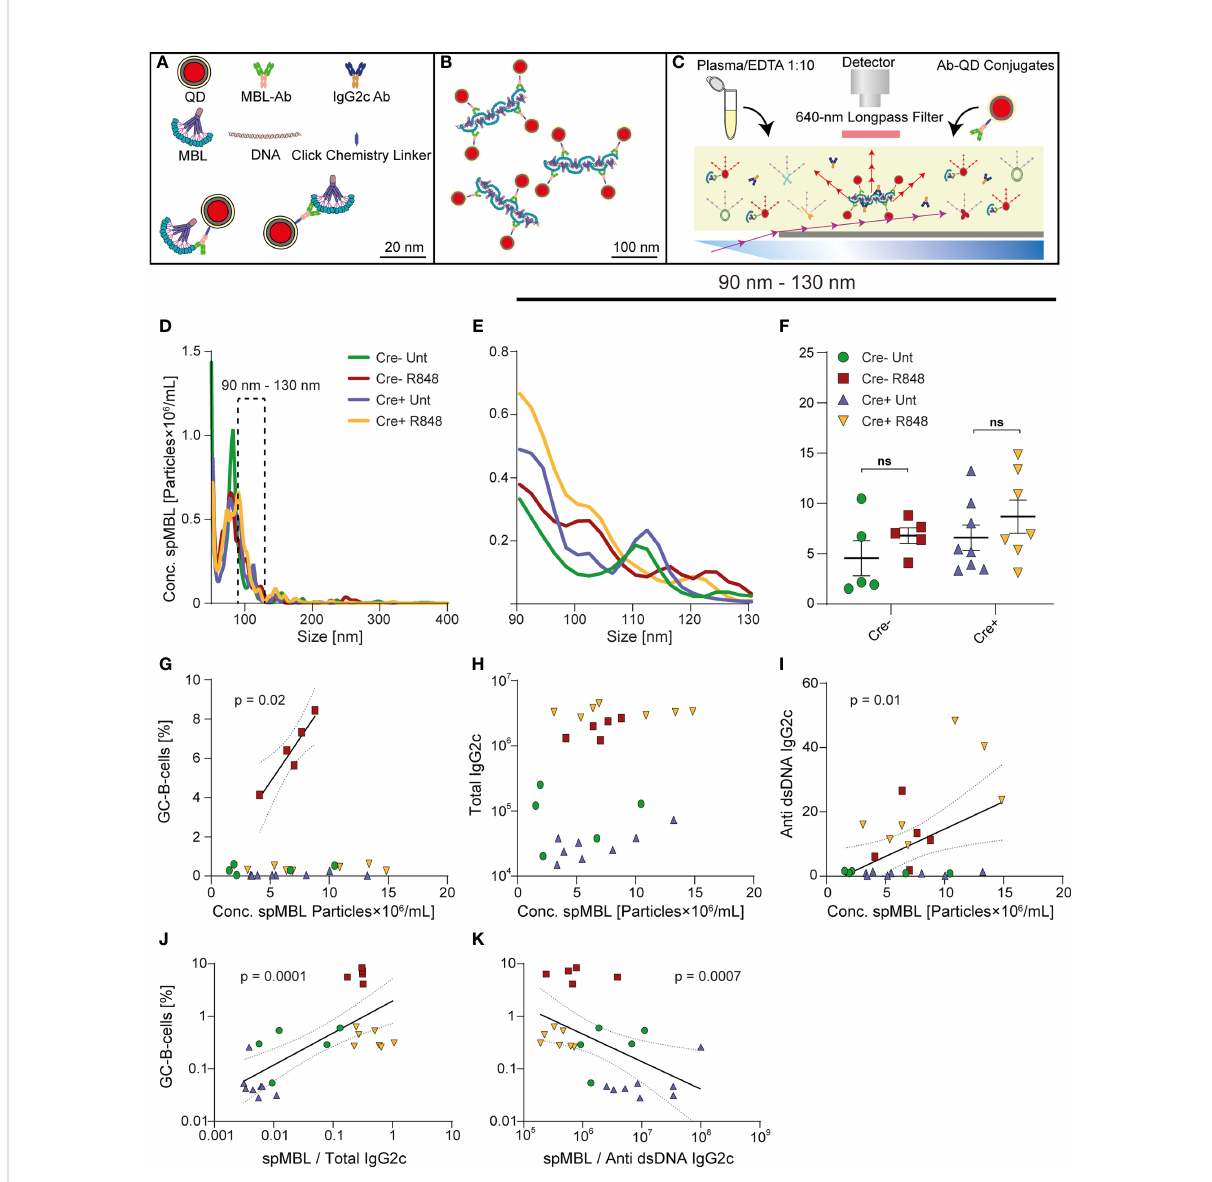
FIGURE 2 Trend towards increased levels of spMBL particles in serum from Cre+ R848 treated mice, and GC and autoantibody correlations with spMBL. (A – C) Schematic overview of experimental setup for spMBL analysis of serum samples. (D) Samples were tested for the size interval 90-130 nm from Aicda-Cre Bcl-6 fl x/ fl x (Untreated: blue, R848-treated: yellow) and Bcl-6 fl x/ fl x littermate controls (Untreated: green, R848-treated: red). (E) Zoom onto the range of 90 to 130 nm. (F) Graph showing mean ± SEM and individual measurements across treatment protocols for Cre- untreated (n=5), Cre- R848-treated (n=5), Cre+ untreated (n=8), and Cre+ R848-treated (n=7) mice. (G) Correlation analysis of GCB vs. Conc. spMBL. (H) Correlation analysis of total IgG2c levels vs. Conc. spMBL. (I) Correlation analysis of anti-dsDNA IgG2c vs. Conc. spMBL. (J) Correlation analysis of GCB cells vs. spMBL/total IgG2c (K) Correlation analysis of GCB vs. spMBL/anti-dsDNA IgG2c. Two-way ANOVA